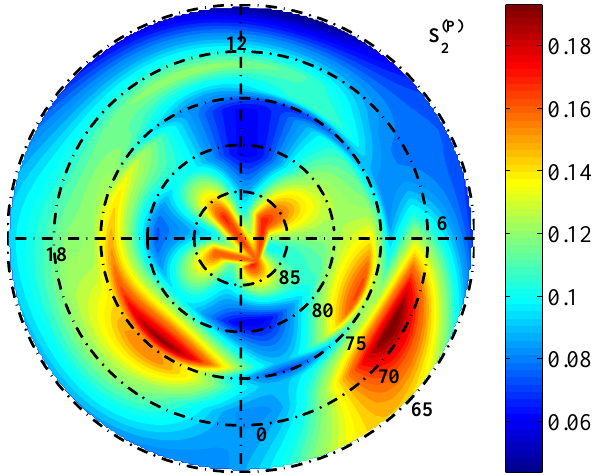
Fig. 11. Variance of the approximation (2) of σ(F,τ) at τ = 180 days, N = 2, calculated for P-component for seven stations, located along MM110 (ABK, BJN, HRN, LYR, NAL, NRD and ALE, sta- tion coordinates are given in Table 1) in dependence on CGM lati- tude and